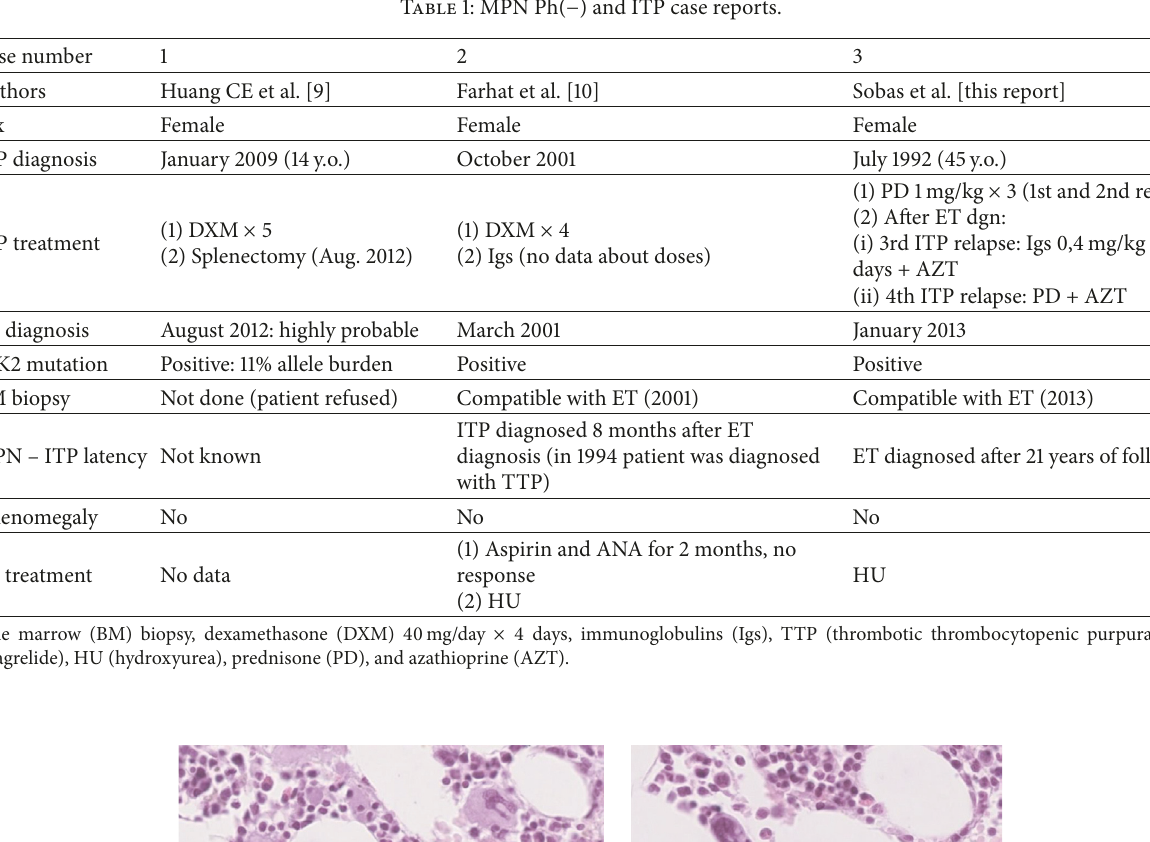
Table 1: MPN Ph( − ) and ITP case reports.